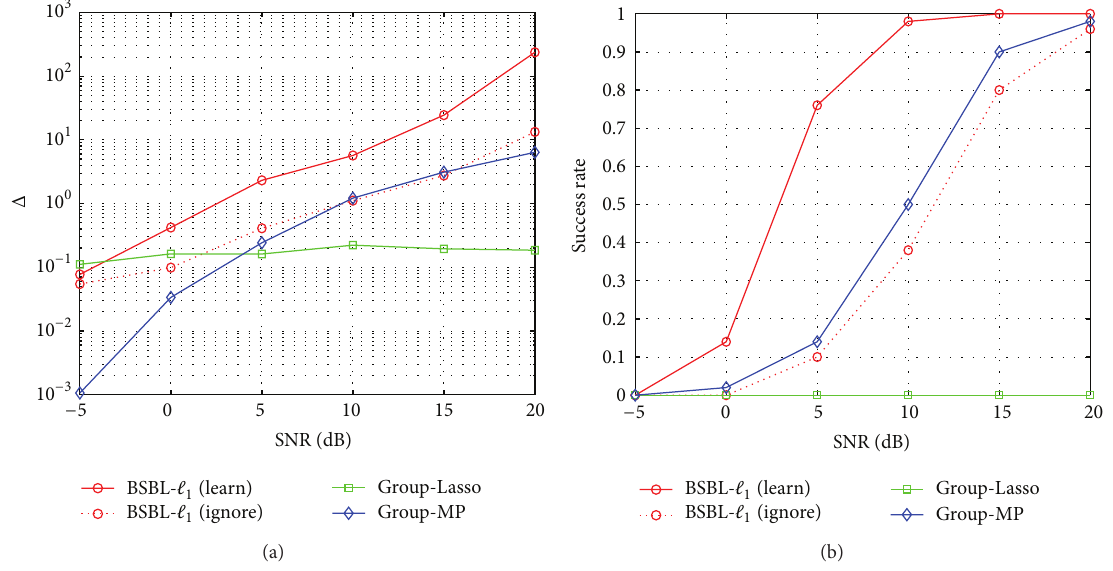
Figure 8: Comparison of metrics versus SNR. Grid distance is 5 m. (a) Δ ; (b) success